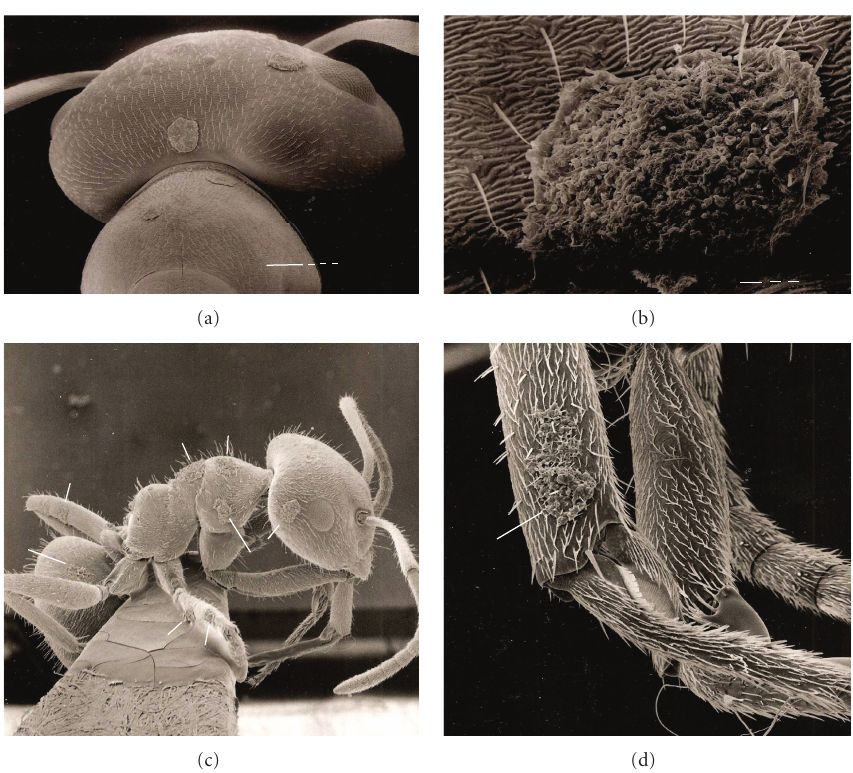
Figure 2: (a) Aegeritella tuberculata on Formica pressilabris (Spain). Two bulbils are in the pronotum, one at the back of head, (b) closeup of a bulbil; (c) A. tuberculata on Lasius grandis from Tenerife, Canary Islands; white arrows indicate bulbils; (d) closeup of bulbils in the first leg.